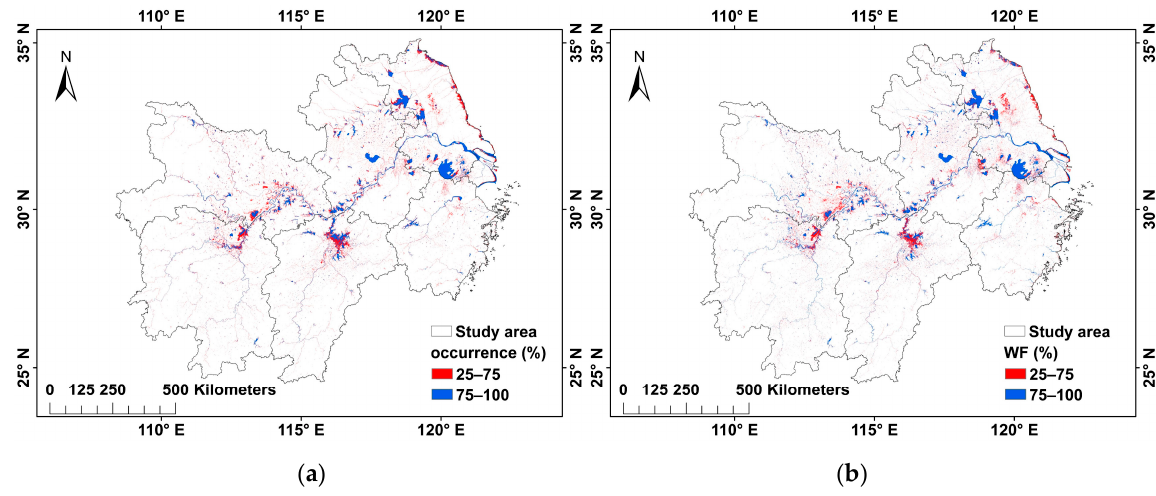
Figure 9. ( a ) JRC Global Surface Water Mapping Layers; ( b ) WF dataset of this paper for the MLYP from 1984 to 2020.